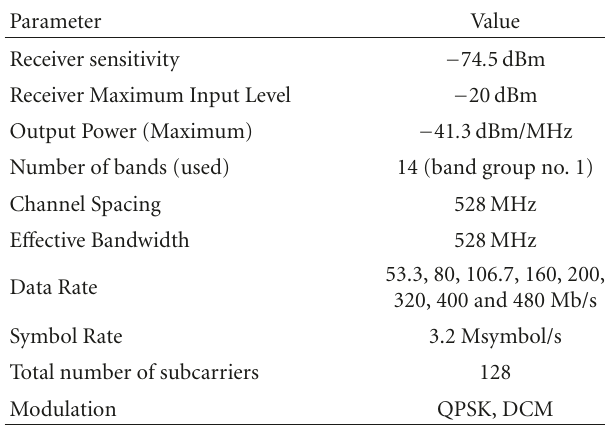
Table 1: Summary of parameters considered for the standard